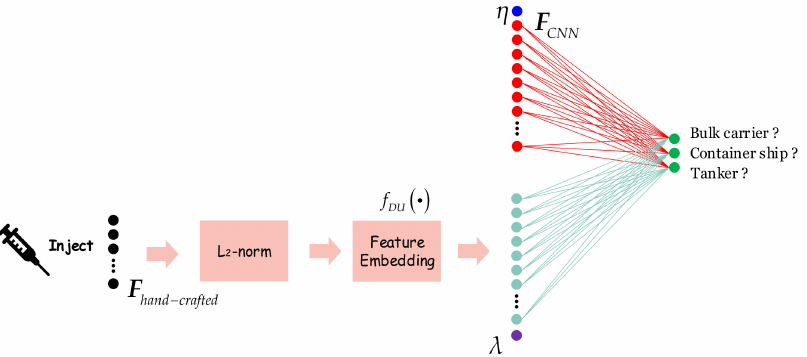
Figure 18. Diagrammatic sketch of the dimension unification weighted concatenation with feature normalization (DUW-Cat-FN).